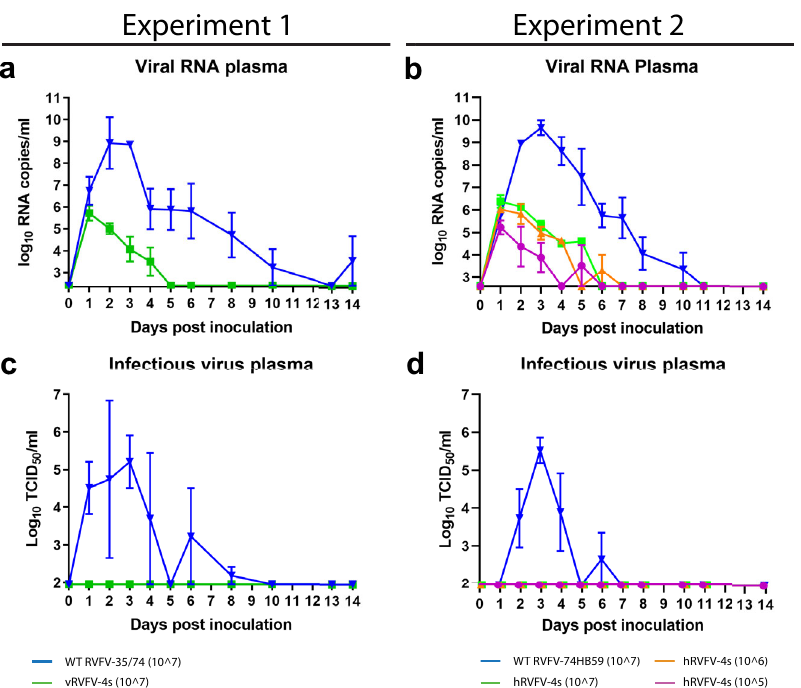
Fig. 5 No infectious virus recovered from plasma of RVFV-4s inoculated marmosets. Plasma samples were assessed for the presence of viral RNA by RT-qPCR ( a , b ) and for infectious virus by virus isolation ( c , d ). Samples that tested negative are depicted at the detection limit of the PCR (2.6 log10 RNA copies/ml) or virus isolation (1.95 log10 TCID 50 /ml). In the fi rst week post inoculation, the animals were allotted to one of two sampling groups. Animals in each group were bled every other day to minimize withdrawal volumes (see Fig. 1). Averages and SEM are presented for each